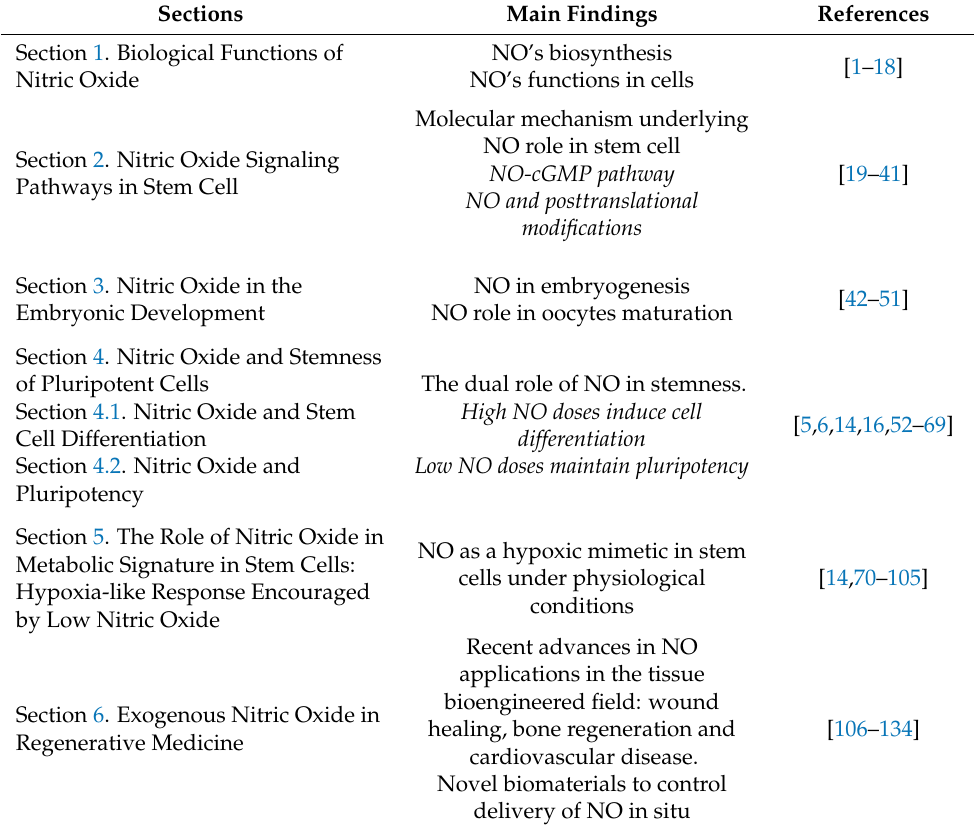
Table 1. The role of NO in stem cells